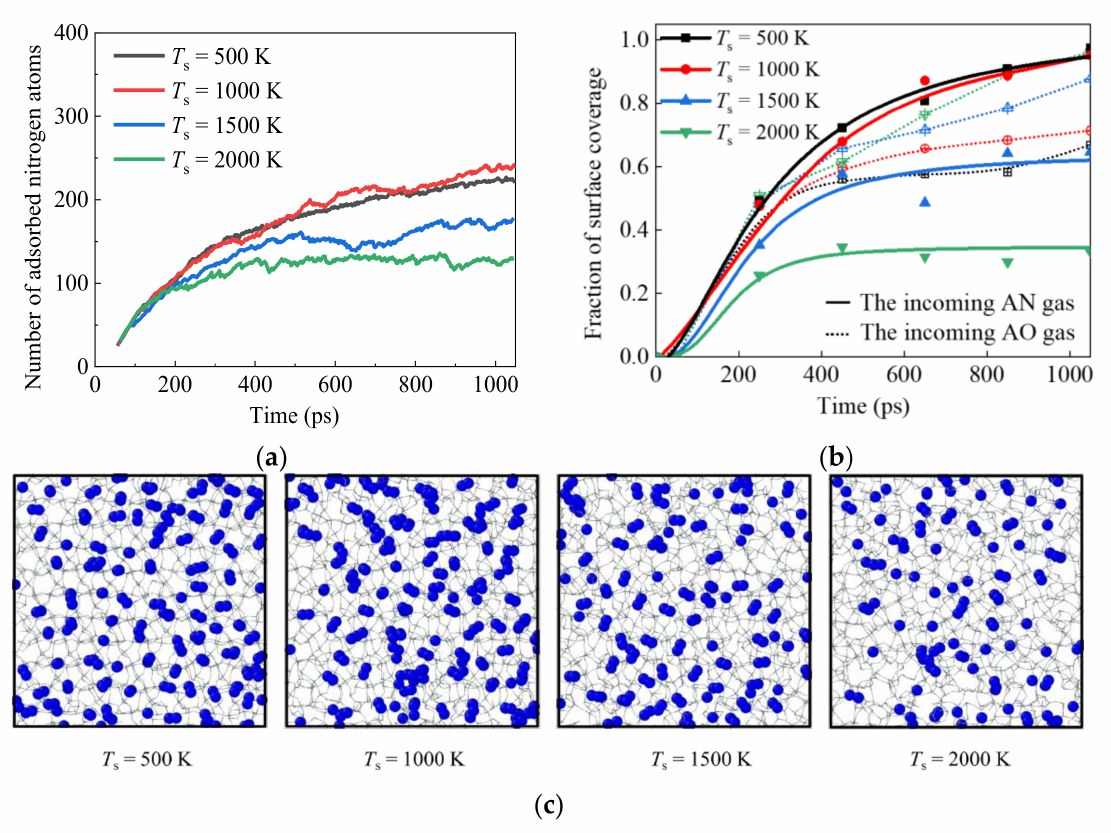
Figure 11. Adsorption of nitrogen atoms on the silica surface with variations in time for the case with the incoming AN gas (Models IV-17–20): ( a ) the effect of surface temperature on the surface adsorption, ( b ) the effect of surface temperature on the surface coverage fraction, and ( c ) snapshots for the final AN surface adsorption status from the view of the x–y plane.